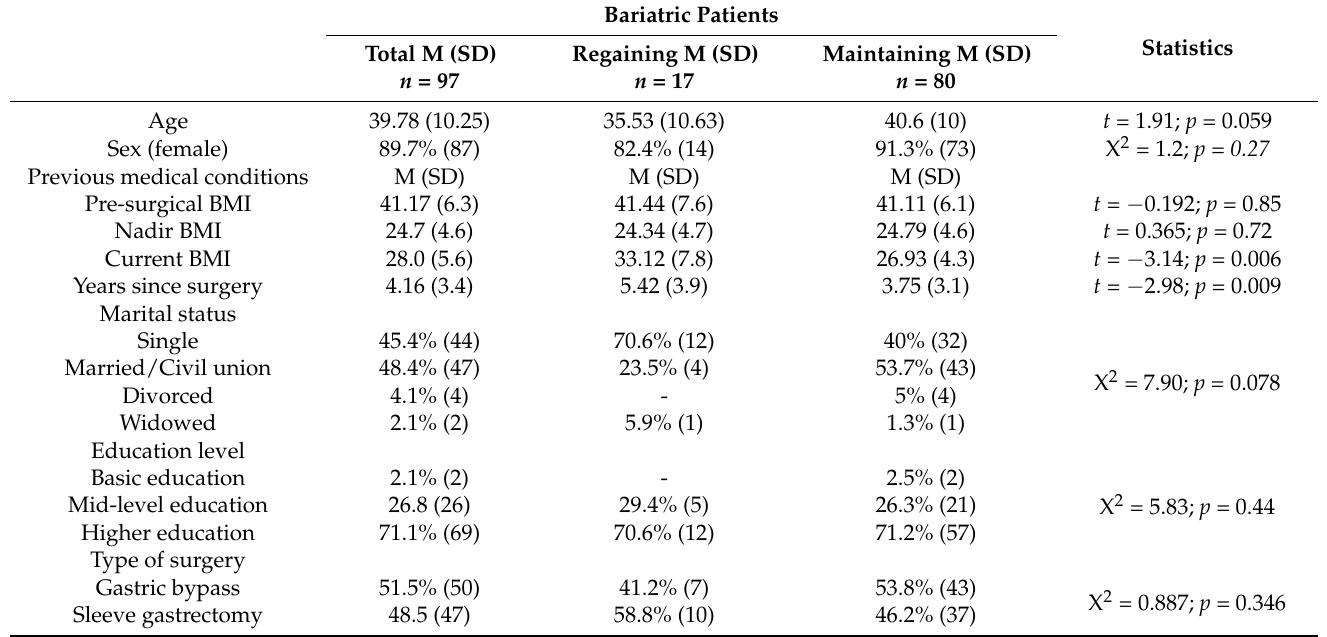
Table 3. Sociodemographic variables in accordance with weight loss status (regaining or